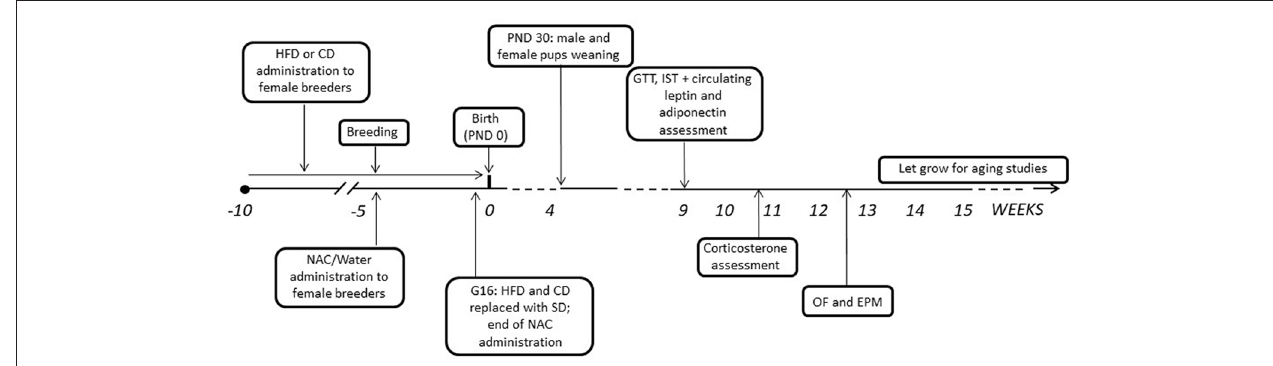
FIGURE 1 | Graphical representation of the experimental timeline. HFD, high-fat diet; CD, control diet; SD, standard diet; NAC, N-acetyl-cysteine; PND, postnatal day; G, gestational day; GTT, Glucose tolerance test; IST, insulin sensitivity test; OF, open field; EPM, elevated plus maze.